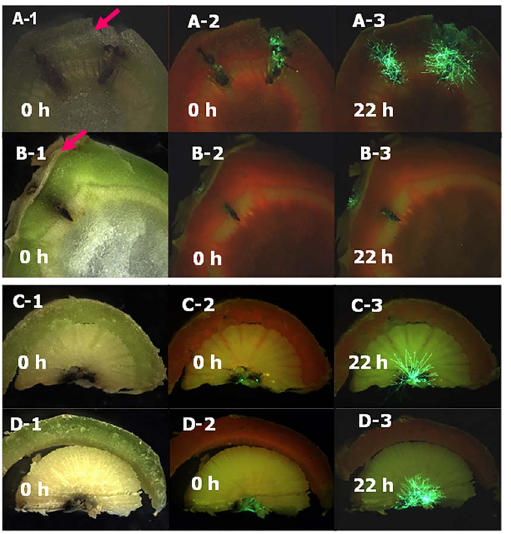
Figure 8. Growth of Leptosphaeriamaculans in the stem cortex or pith. Leaf petioles of oilseed rape doubled haploid lines A30 (susceptible) or C119 (with quantitative resistance) were inoculated with conidia of GFP-expressing L. maculans isolate ME24/3.13, stems of A30 (A, C) and C119 (B, D) were cut horizontally at the leaf scar (A, B) of the inoculated leaf or at the hypocotyl (C, D) 2–3 cm below the leaf scar at 87 days post inoculation (dpi). Stem cross-sections were viewed with brightfield illumination (A-1, B-1, C-1, D-1) or a GFP2 filter (A-2-3, B-2-3, C-2-3, D-2-3) immediately after cutting (0 h) or after incubation for 22 hours in darkness at 20 u C (22 h).